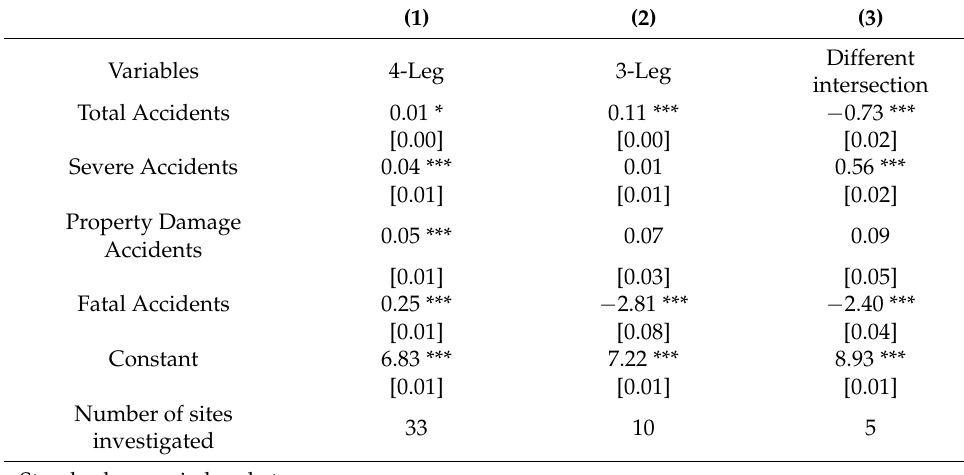
Table 4. Correlation between red light violations and different types of accidents.